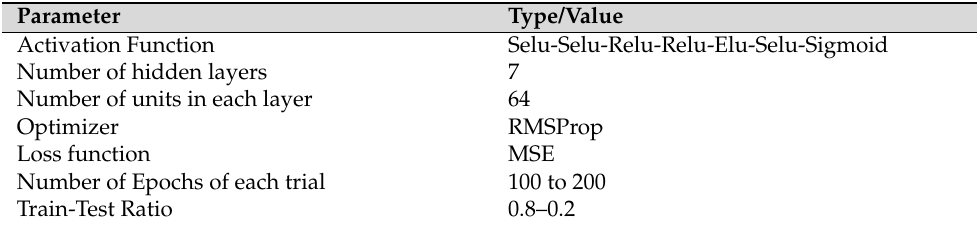
Table 5. Input parameters for the best results obtained with the proposed ECG biosensor.